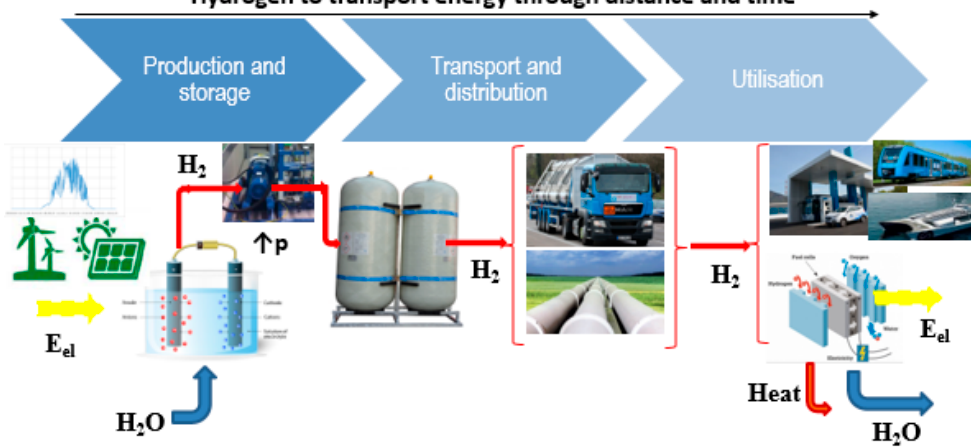
Figure 2. Power to Hydrogen (P2H) chain: (1) hydrogen production by water electrolysis and renewable energy, hydrogen storage, hydrogen distribution and hydrogen final consumption.